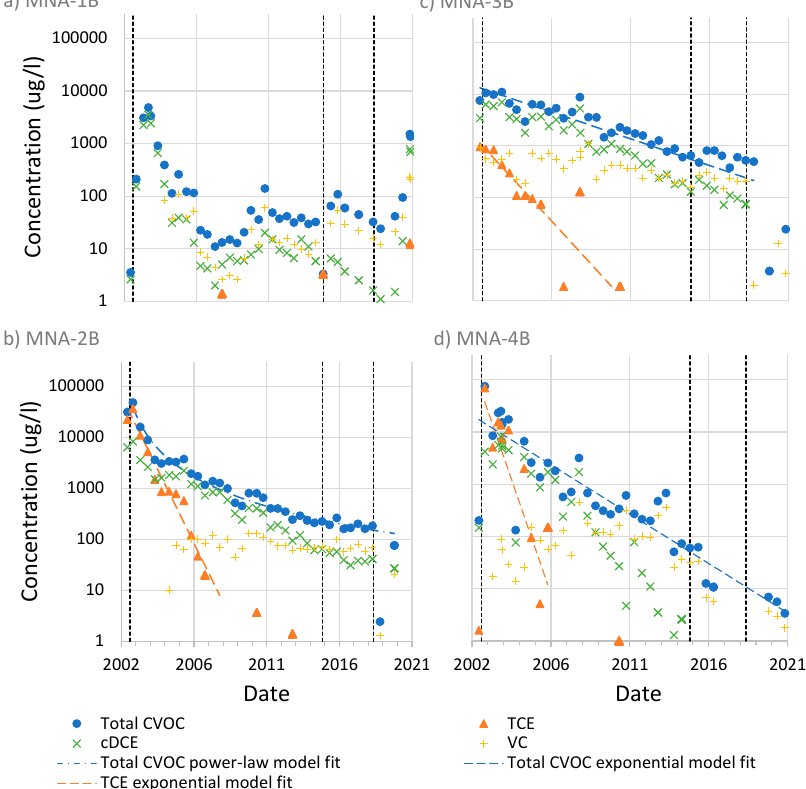
Figure 2. Concentration–time series for monitoring wells ( a ) MNA-1B, ( b ) MNA-2B, ( c ) MNA-3B, and ( d ) MNA-4B at the PFC site in Cocoa, Florida. Model fits are shown for select data only. The power law model fit for total CVOC in panel ( b ) is based on an exponent of 2. The vertical dashed lines indicate the following events from left to right: start of the PAT system in 2002, first biotreatment injection in 2015, and second biotreatment injection in 2019. Data shown in the graphs were taken from Geosyntec [63].